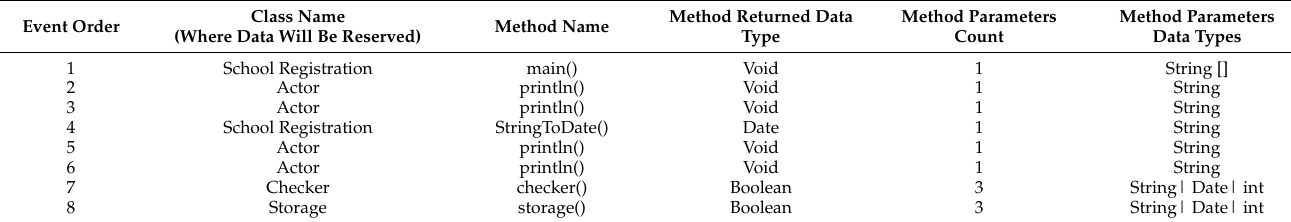
Table 4. Event’s body data structure.